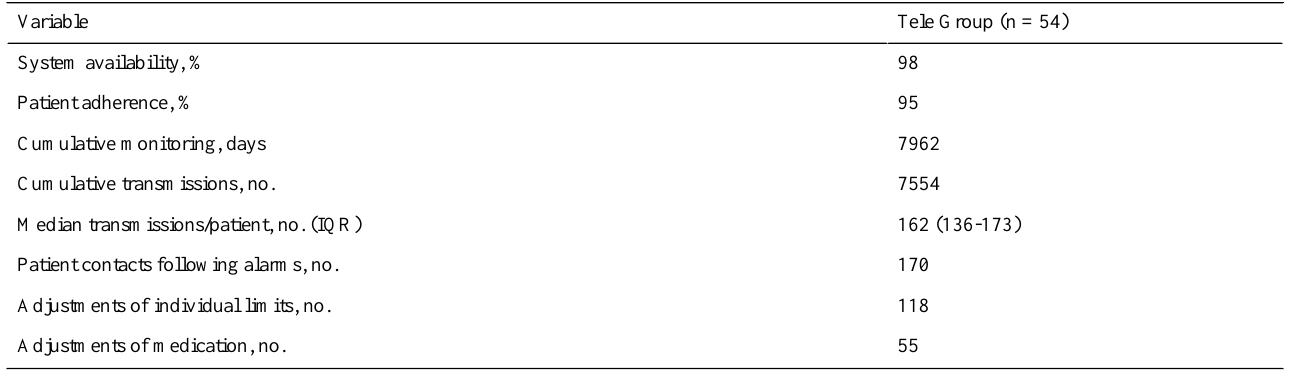
Table 2. Technical data and interventions in the telemedicine arm